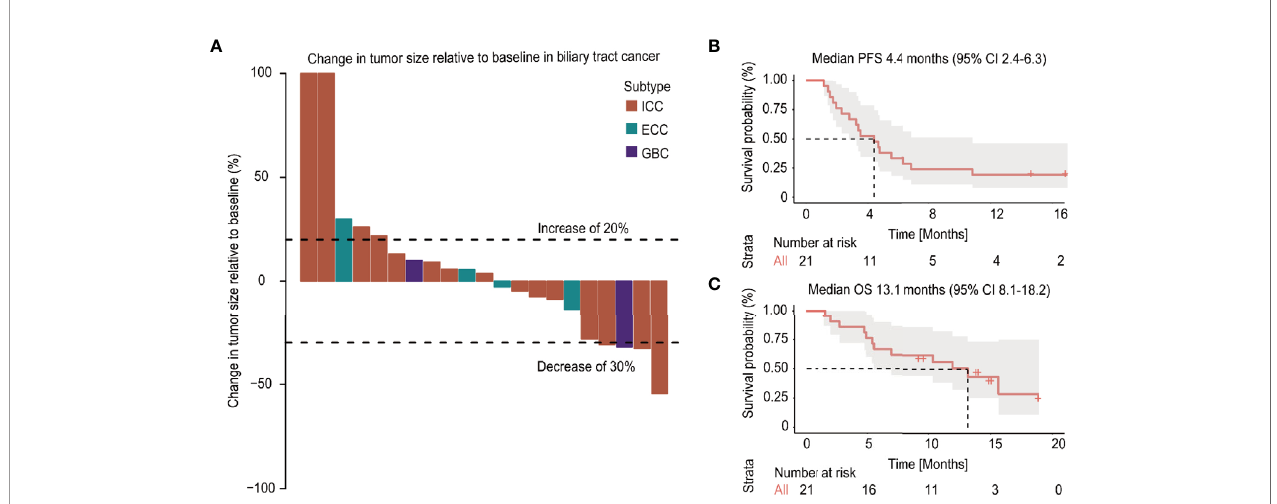
FIGURE 2 | Changes in tumor burden from baseline of the response-evaluable patients and survival plot (A) . Kaplan-Meier curves of the progression-free survival (PFS) (B) and overall survival (OS) (C) of patients with biliary tract cancer (BTC) treated with apatinib plus camrelizumab.